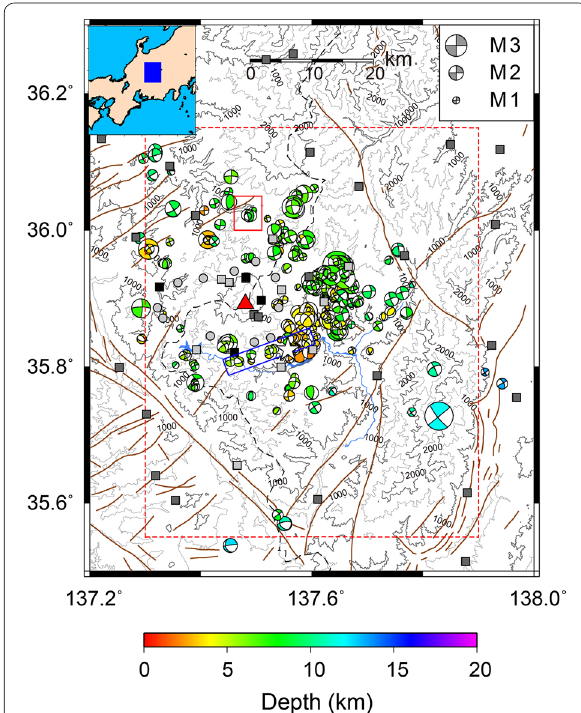
Fig. 1 Topographic map of Mt. Ontake volcano, seismic stations, and 379 focal mechanisms with M 1. Focal mechanism solutions are ≥ represented by the lower-hemisphere projection of focal spheres, and the color scale corresponds to focal depth. The dashed rectangle in red represents the model region in the present FMT analysis. The red triangle indicates Mt. Ontake. The solid circles and squares mark temporary and permanent seismic stations, respectively. The light gray , dark gray , and black symbols denote seismic stations organized by Nagoya University, national institutes (the Japan Meteorological Agency and NIED), and Gifu and Nagano prefectures, respectively. The white star and the blue rectangle denote the epicenter and the source region of the 1984 Western Nagano prefecture earthquake. The brown lines indicate active faults. The dashed black line marks the prefectural boundary between Gifu and Nagano prefectures. The red rectangle denotes the events that were triggered between June